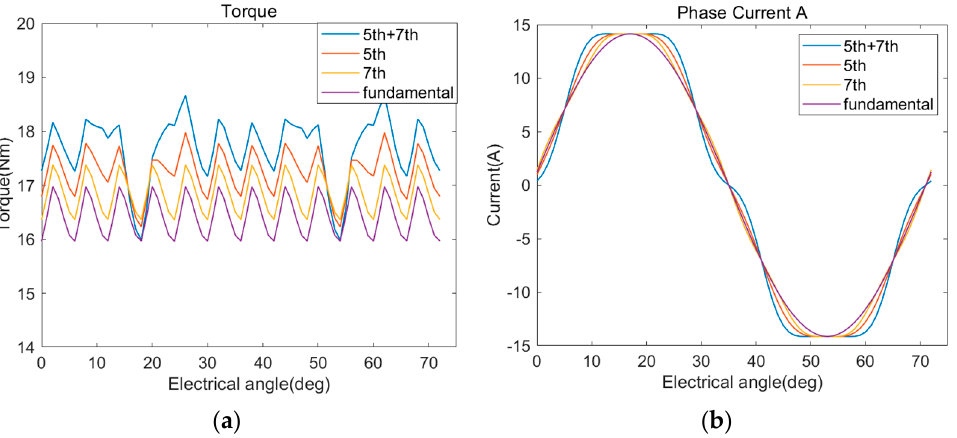
Figure 7. Torque and stator current calculations via FEM at 10 Arms: ( a ) torque; ( b ) phase current A.